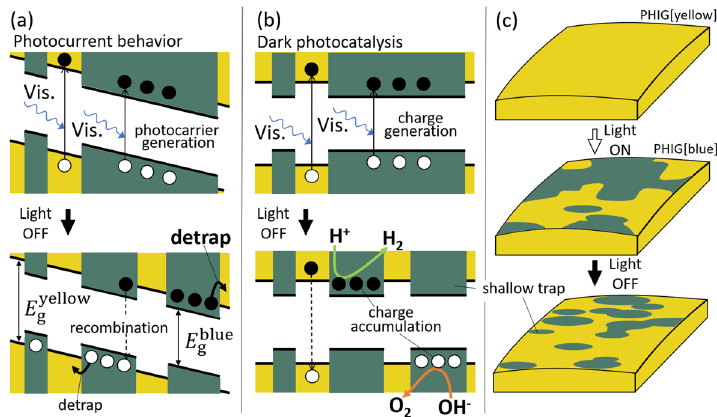
Figure 10. The shallow trap charge accumulation (STCA) model of PHIG. Upper parts of ( a ) and ( b ) show the energy diagrams of PHIG under light irradiation. The bottom parts of ( a ) and ( b ) show the energy diagrams of PHIG in the dark after stopping light irradiation. ( c ) Schematic of the change in the appearance of PHIG after light irradiation and after terminating irradiation. ( a ) Energy diagrams under a constant applied voltage, explaining the behavior of the photocurrent in Fig. 8. ( b ) Energy diagrams explaining dark photocatalysis by PHI. In the dark state after turning the light off, a portion of the carriers is left behind in the PHIG[blue] areas because the connections between the PHIG[blue] areas are severed. As the PHIG[blue] areas shrink, they become shallow charge traps, leading to increasing trapped charge, and some of the charge accumulates in the PHIG[blue] areas in